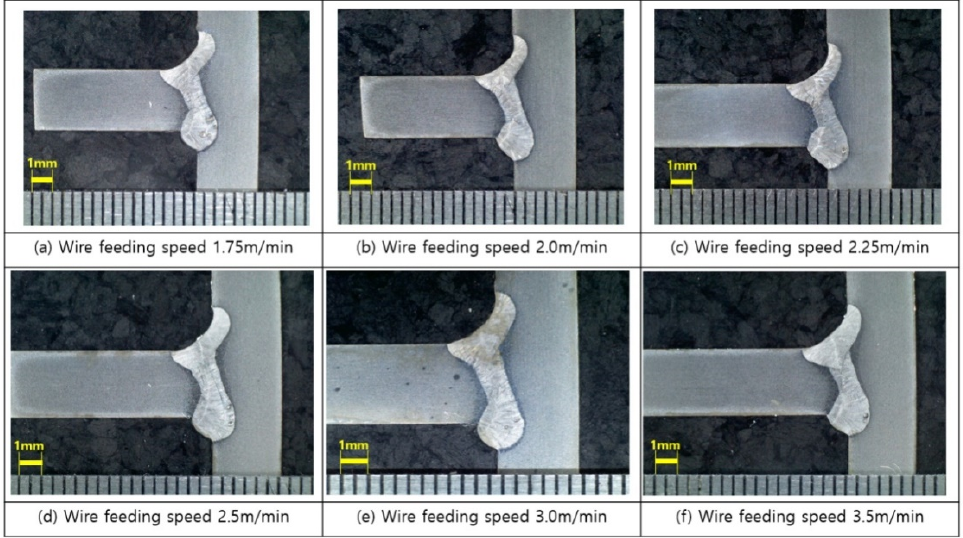
ff erent wire feeding speeds with 0.5 mm beam Figure 15. Different wire feeding speeds with 0.5 mm beam location. Figure 15. Di Figure 15. Different wire feeding speeds with 0.5 mm beam location.